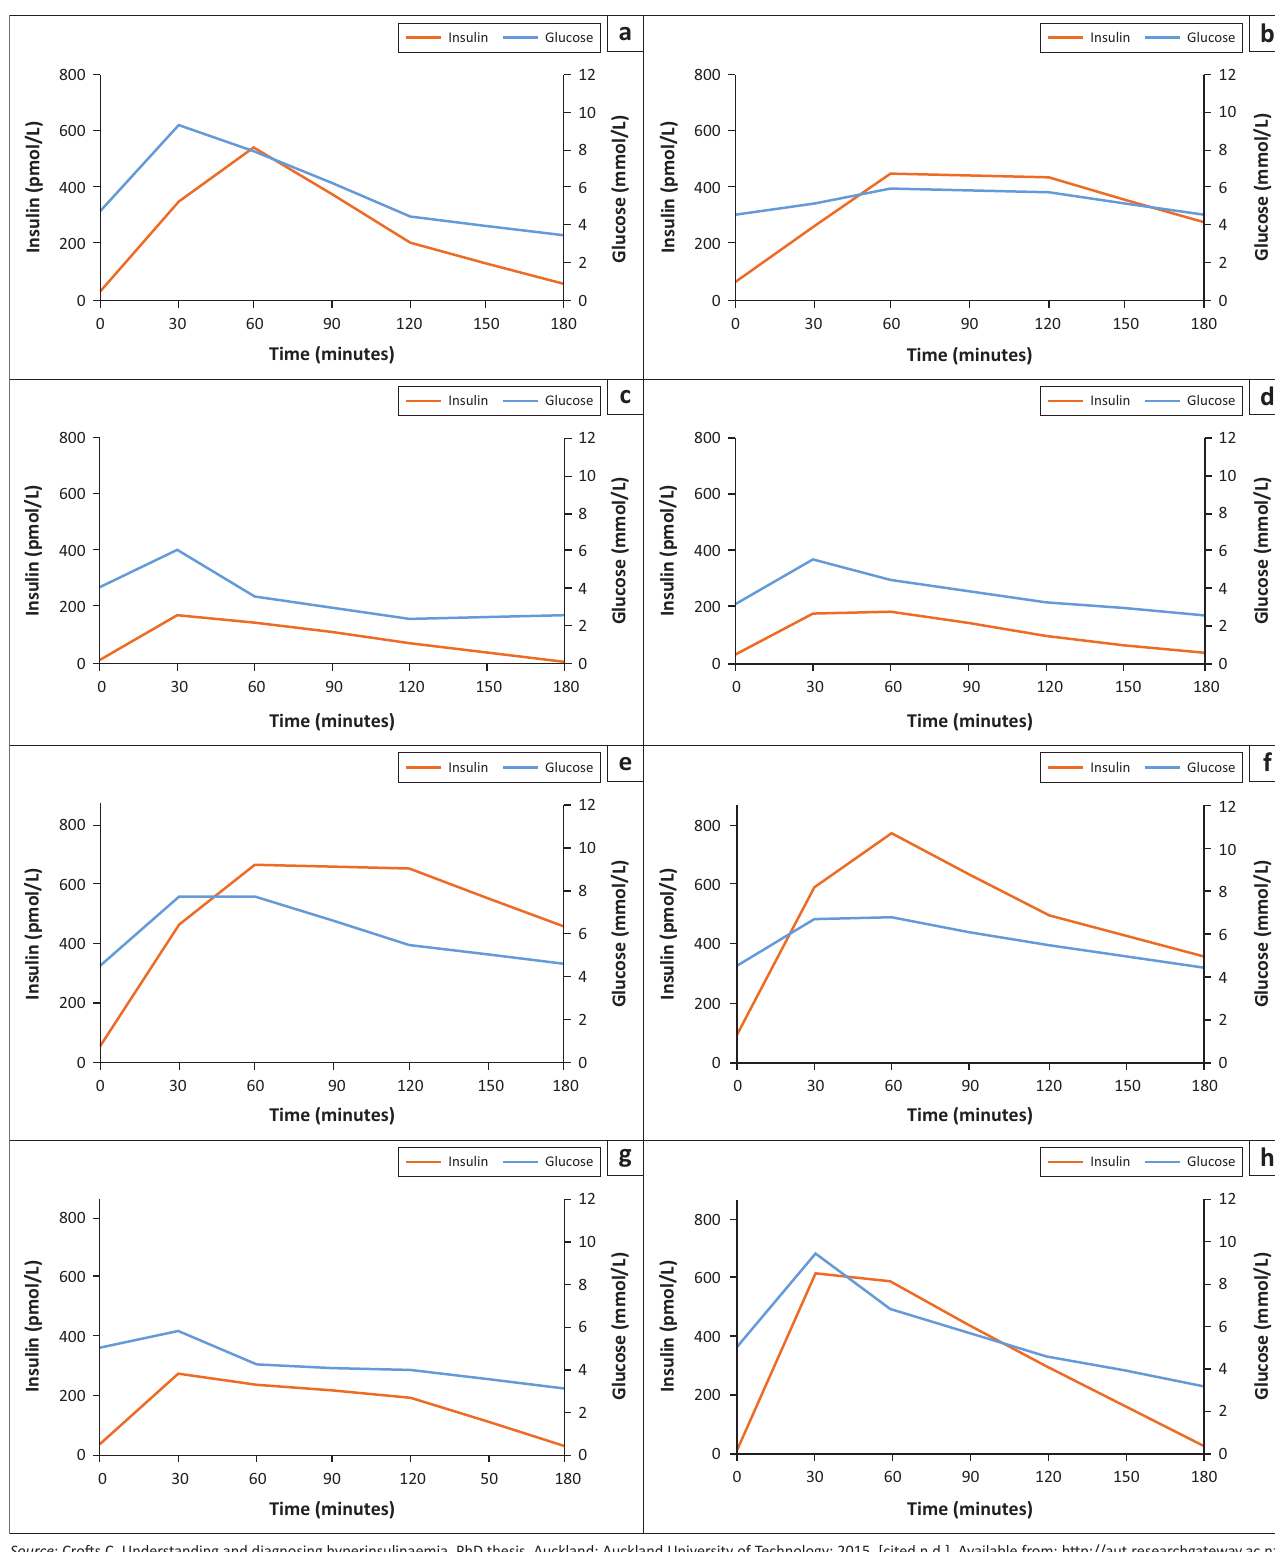
FIGURE 1: Point-wise arithmetic mean insulin (pmol/L) and glucose (mmol/L) concentrations for each participant: (a) K1; (b) K2; (c) K3; (d) K4: weeks 2-4; (e) K5: two test; (f) K6: weeks 2-4; (g) K9; (h) K10: three